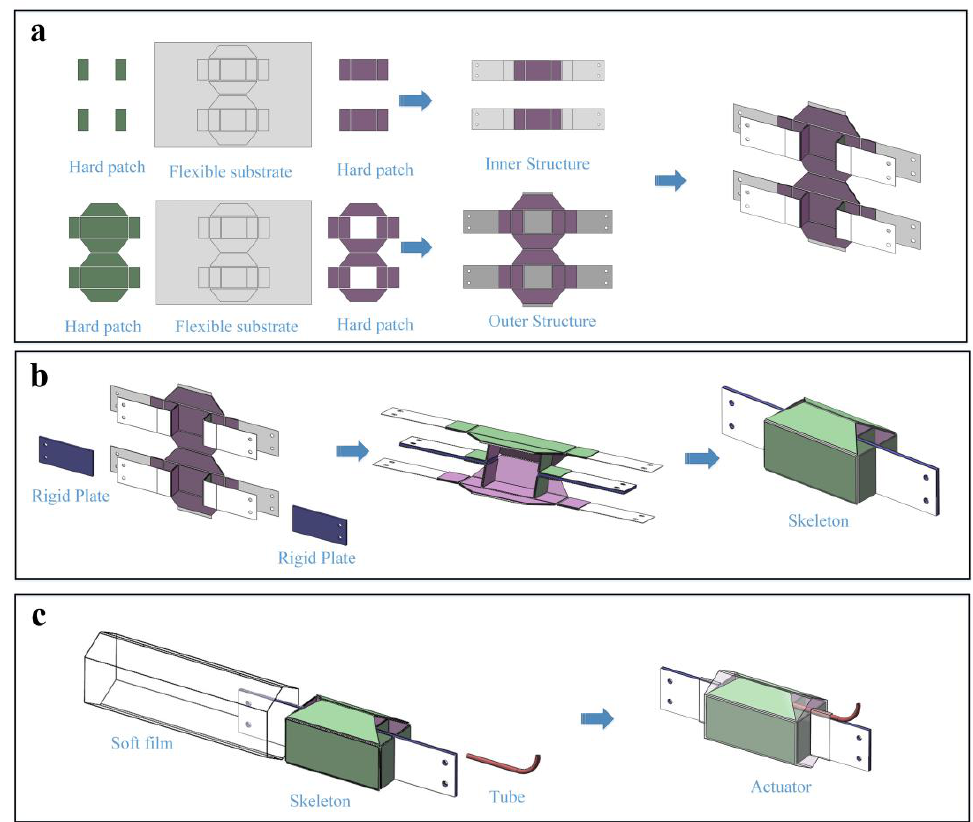
Figure 4. The fabrication process of the actuator with a patched skeleton: ( a ) Paste the hard patch on the flexible substrate; ( b ) Combine the rigid patch and the soft substrate into a skeleton; ( c ) Seal the skeleton with a flexible film to obtain an actuator.